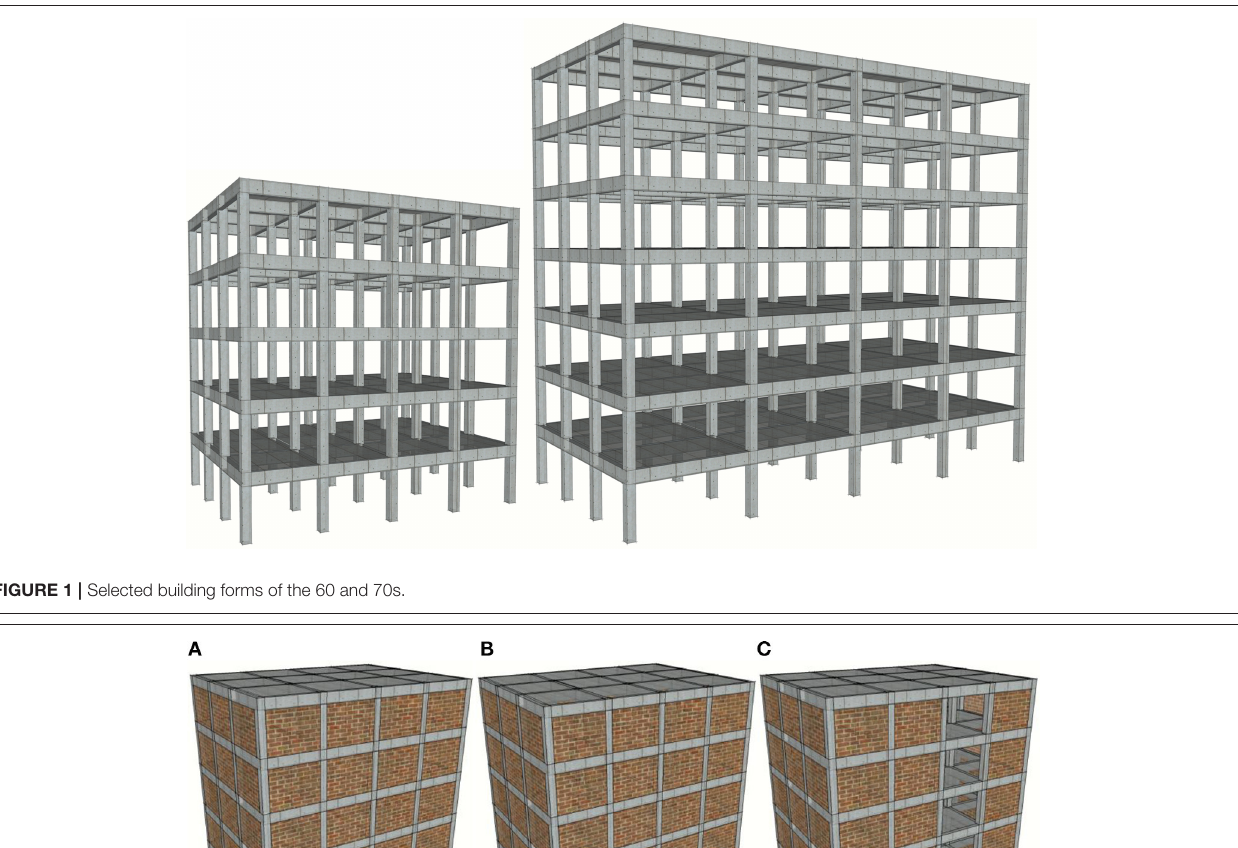
FIGURE 2 | Distribution of masonry infilled walls. (A) T1, (B) T2, (C)